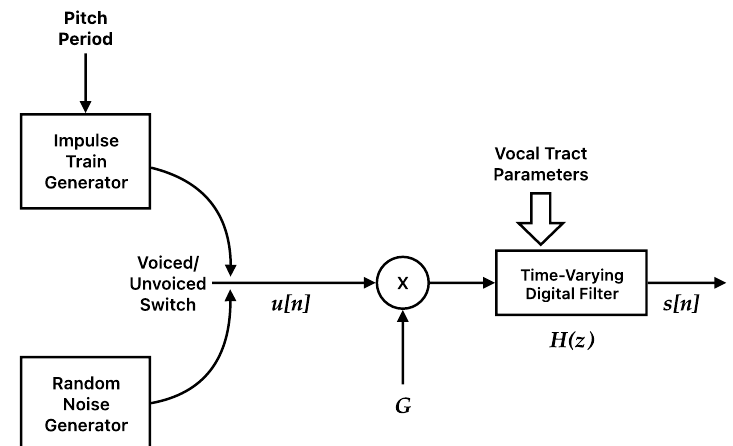
Fig. 4 Basic LPC decoder. All-pole synthesizer is excited by a binary choice between random noise (for unvoiced speech) and impulses (for voiced